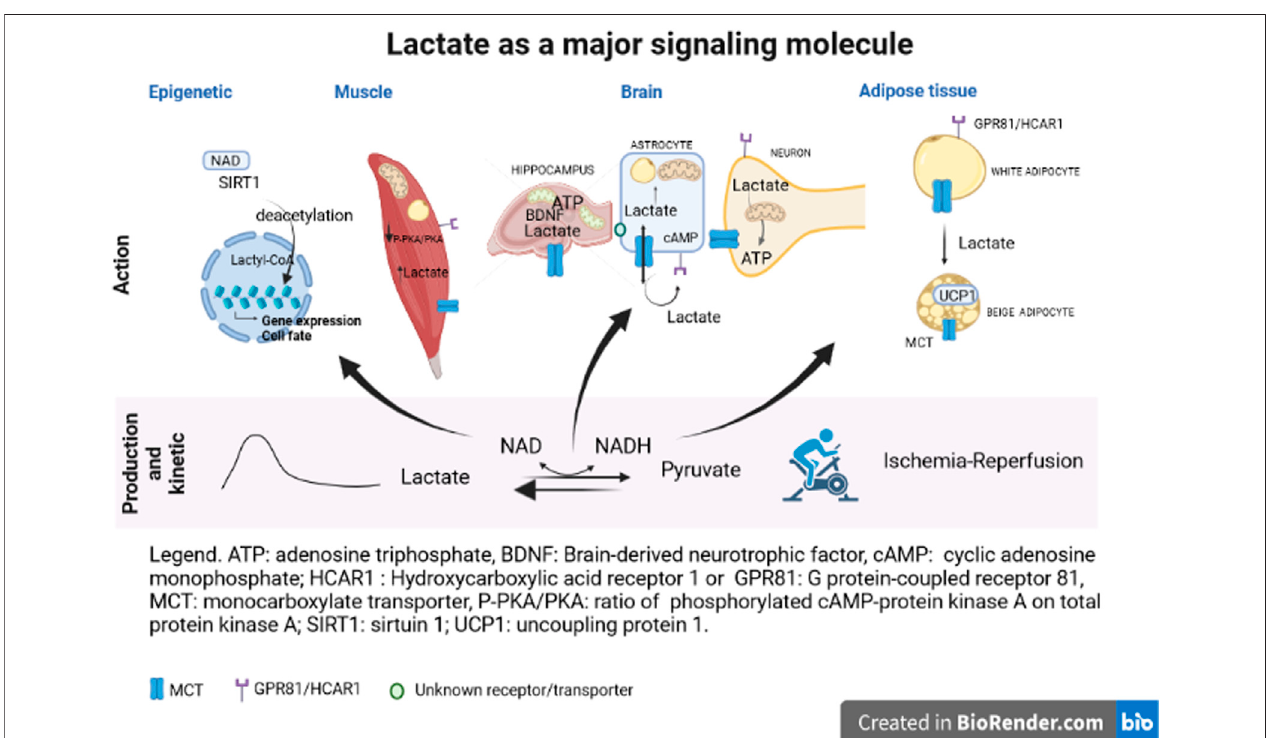
FIGURE 1 | ATP, adenosine triphosphate; BDNF, brain-derived neutrophic factor; cAmp, cyclic adenosine monophosphate; HCAR1, hydroxycarboxylic acid receptor 1 or GPR81, G protein-coupled receptor 81; MCT, monocarboxylate transporter; P-PKA/PKA, ratio of phosphorylated cAMP-protein kinase A on total protein kinase A; SIRT1, sirtuin 1; UCP1, uncoupling protein